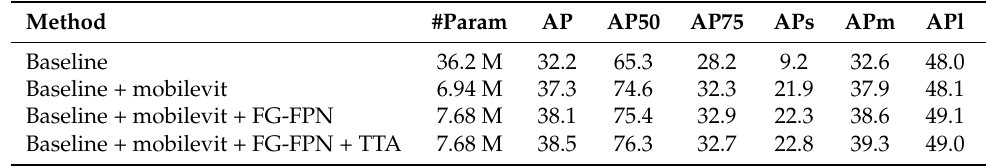
Table 2. Effectiveness of each part of our model.